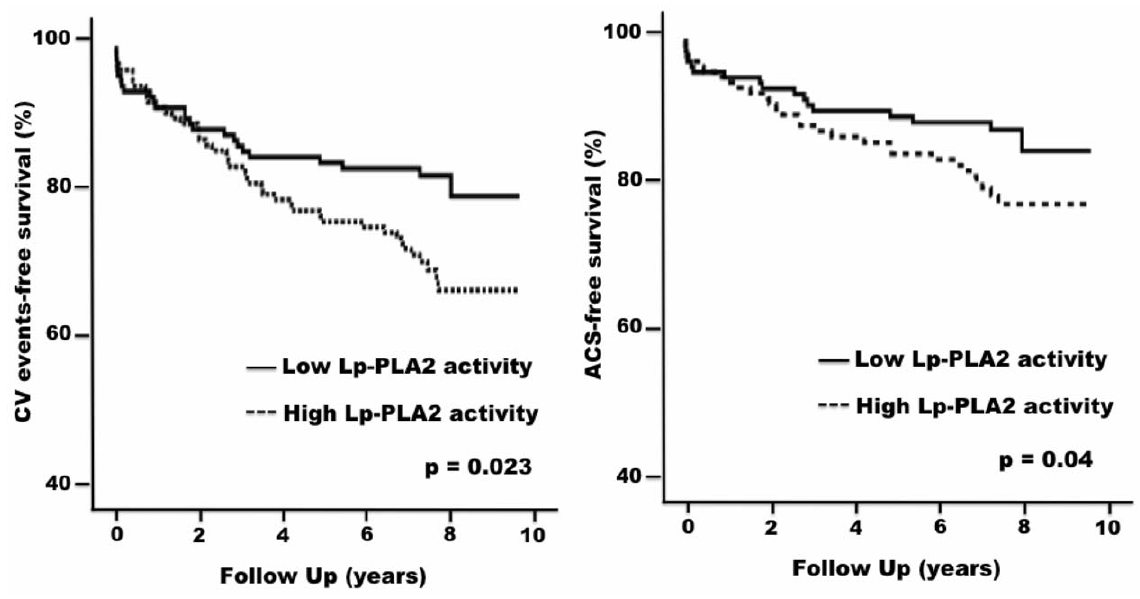
Figure 4. Cardiovascular events- and acute coronary syndromes-free survival. Kaplan-Meier curves show cardiovascular (CV) events- (left Panel) and acute coronary syndromes (ACS)-free survival (right Panel) in the propensity score-matched high-risk patients divided into the high and low Lp-PLA2 activity group. Patients with high Lp-PLA2 activity had a significantly lower CV events-free survival and a significantly lower ACS-free survival.